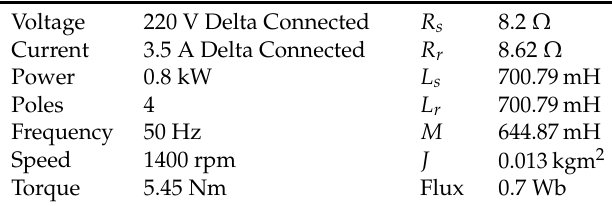
Table 1. Parameters of a three-phase induction motor.